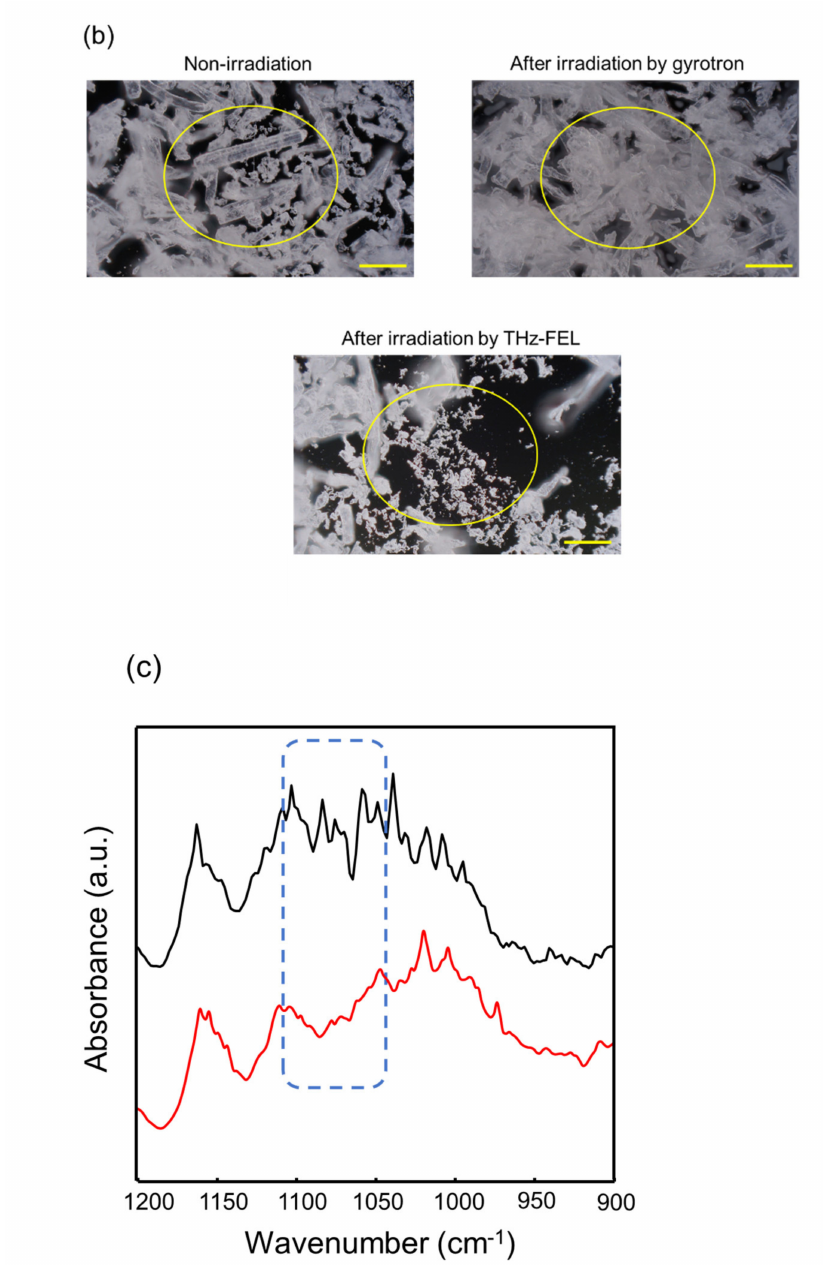
Figure 4. Irradiation effects of THz-FEL and submillimeter wave on cellulose fiber. ( a ) Infrared spectra. Black: non-irradiation; blue: irradiation with THz-FEL; red: irradiation with submillimeter wave; green: irradiation with submillimeter wave behind THz-FEL. ( b ) SEM observation. Upper left: non-irradiation; upper right: irradiation by submillimeter wave; below: irradiation by THz-FEL. Yellow bar: 100 µ m. ( c ) Infrared spectra before (black) and after (red) irradiation by mid-infrared FEL at 9.1 µ